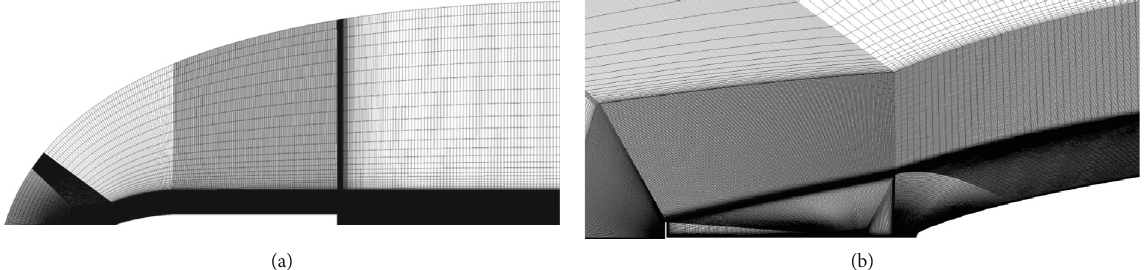
Figure 6: The mesh of Carmen curve bodies with aerospike. (a) Global mesh. (b) Mesh of the